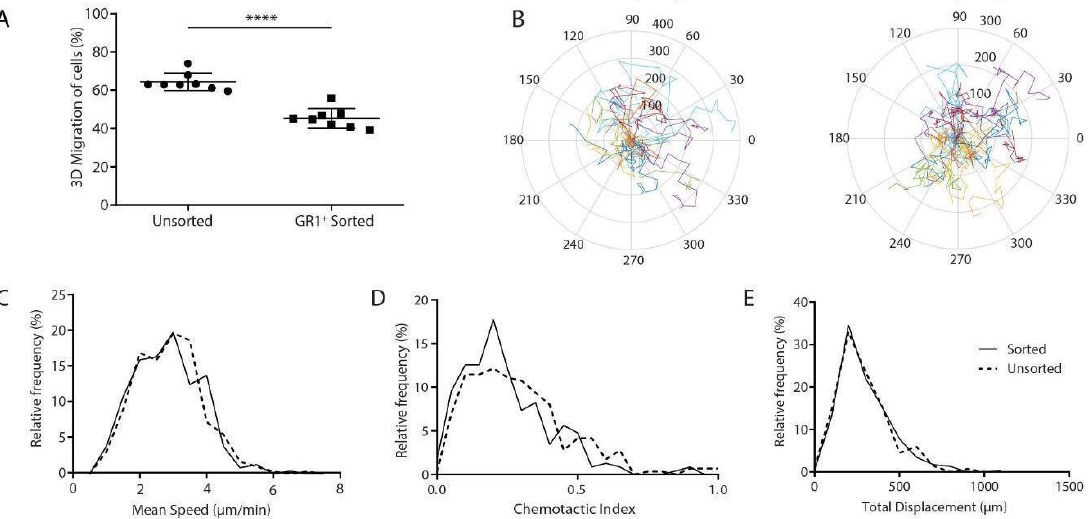
Figure 2. GR1+ cells sorted from splenocytes have reduced overall migration. ( A ) Quantification of unsorted and sorted splenocyte percent migration in our 3D in vitro model ( n = 4; bars and error represent mean ± SEM, ****, p < 0.005). ( B ) Representative polar plots of migration tracks of unsorted and sorted splenocytes through live imaging. ( C – E ) Histograms of mean, chemotactic index, and displacement of unsorted (dashed line) and sorted (solid line) cells across live imaging experiments. All data in histograms represented across live imaging experiments with statistical significance were confirmed in the chemotactic index between the unsorted and sorted population of GR1 + cells through the Kolmogorov – Smirnov test ( p < 0.05).